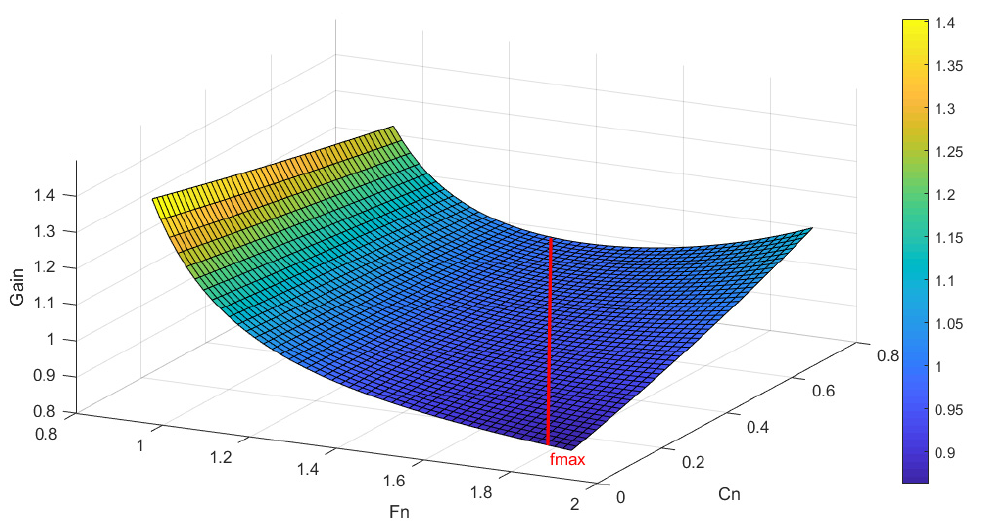
Figure 4. LLC resonant converter voltage gain with effect 0.1 ≤ C n ≤ 0.6 while Q = 0.1.